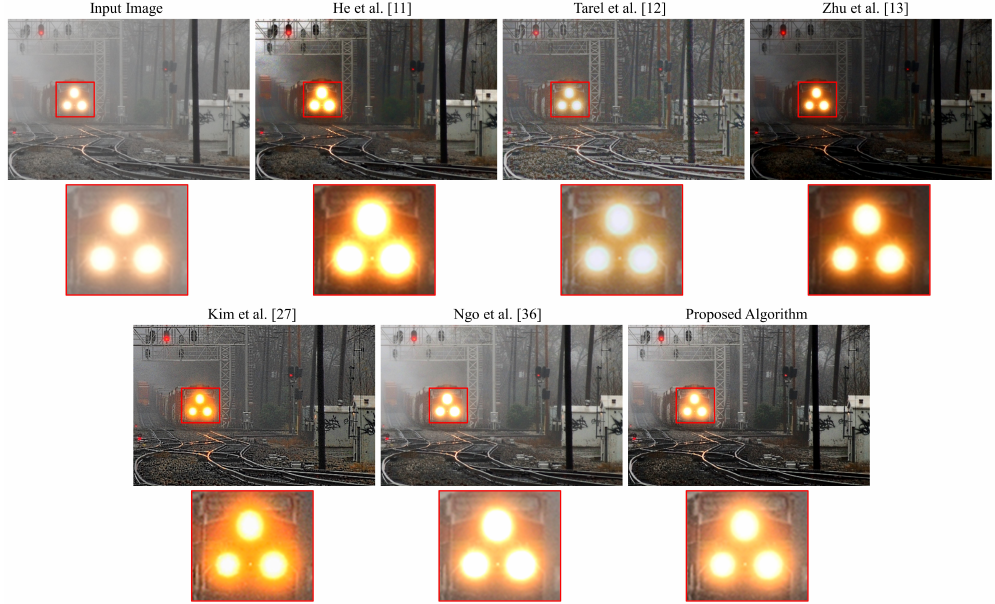
Figure 11. Qualitative assessment of the outputs produced by different algorithms on an image of a